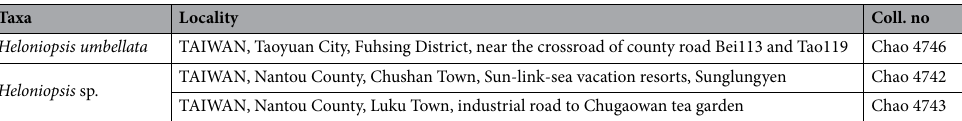
Table 3. Collection information of Heloniopsis taxa for newly